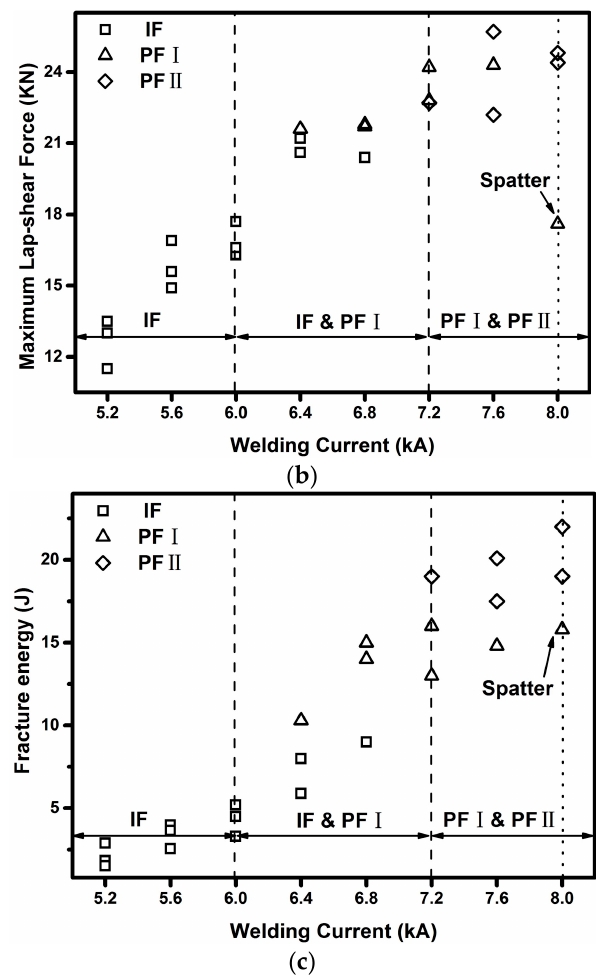
Figure 6. ( a ) Schematic of lap shear strength and fracture energy; and effect of welding current on the: ( b ) lap shear force; ( c ) fracture energy.